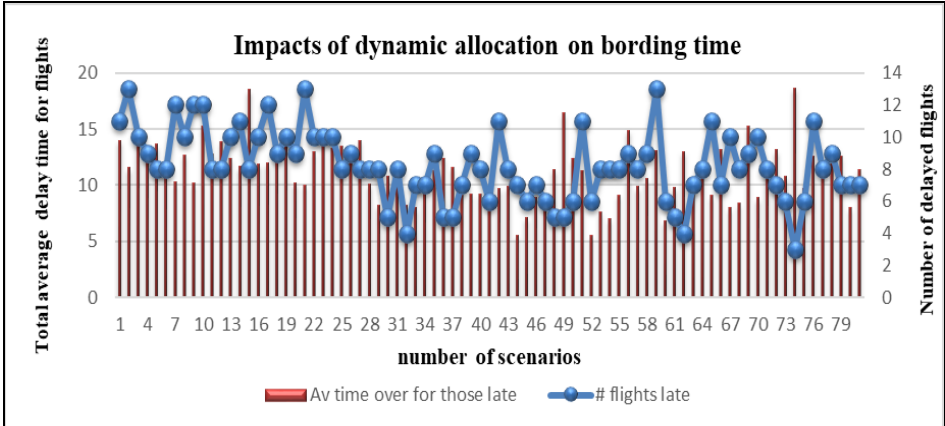
Figure 9. Influence of the dynamic resource allocation method on boarding procedures.